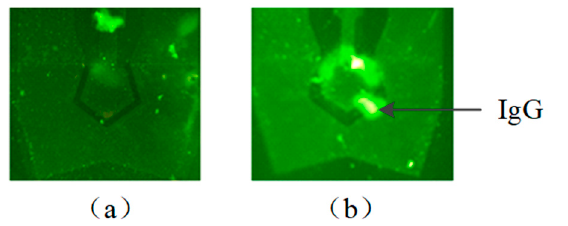
Figure 4. Fluorescence microscope images ( a ) without accumulation ( b ) with accumulation for 10 min .